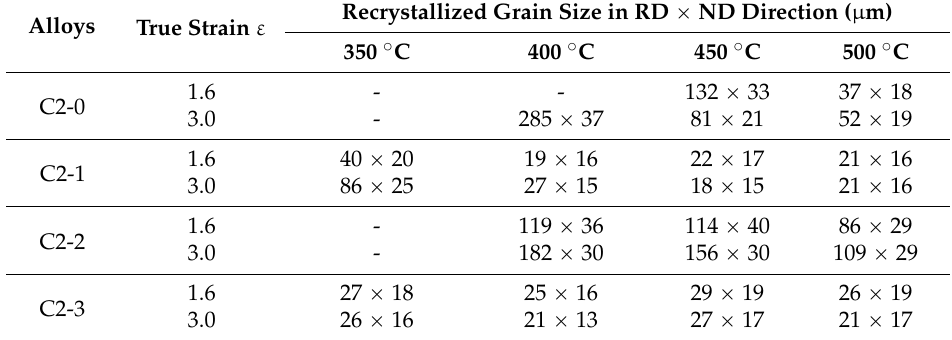
Table 5. Recrystallized grain sizes of the different material conditions cold rolled to strains of ε = 1.6 and 3.0, respectively, after annealing at different temperatures for 10 5